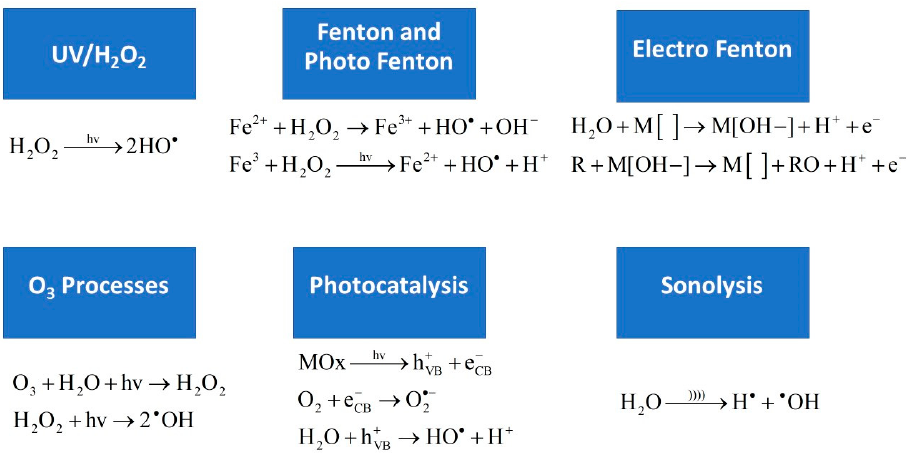
Figure 6. Overview of the mechanisms in AOP.